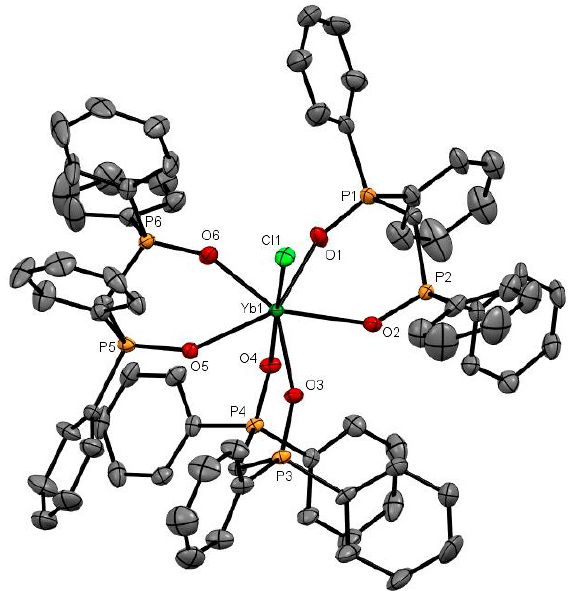
Figure 4. The X-ray structure of [Yb(dppmO 2 ) 3 Cl]Cl 2 . The chloride anions and solvate molecules are omitted. Selected bond lengths (Å) and angles ( ◦ ): Yb1–Cl1 = 2.5834(9), Yb1–O1 = 2.298(3), Yb1–O2 = 2.282(3), Yb1–O3 = 2.250(2), Yb1–O4 = 2.248(2), Yb1–O5 = 2.338(2), Yb1–O6 =